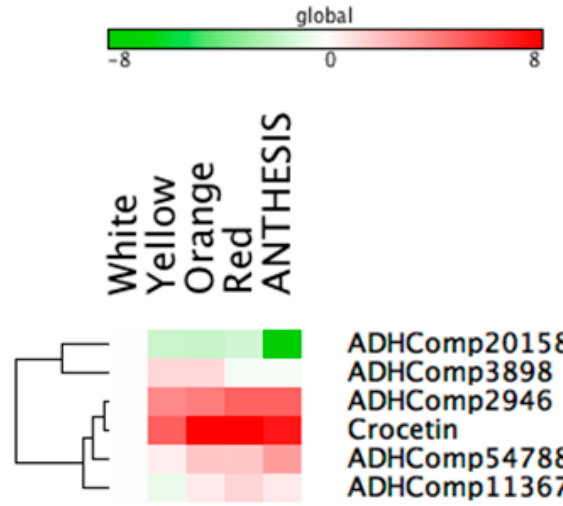
Figure 7. Hierarchical clustering (HCL) of crocetin and aldehyde dehydrogenase (ADH) found in the saffron proteome. Green and red squares represent the values of log2-transformed relative data with respect to the white stage according to the color scale shown. Hierarchical clustering was calculated on rows, applying the Pearson correlation coefficient with the average linkage algorithm.